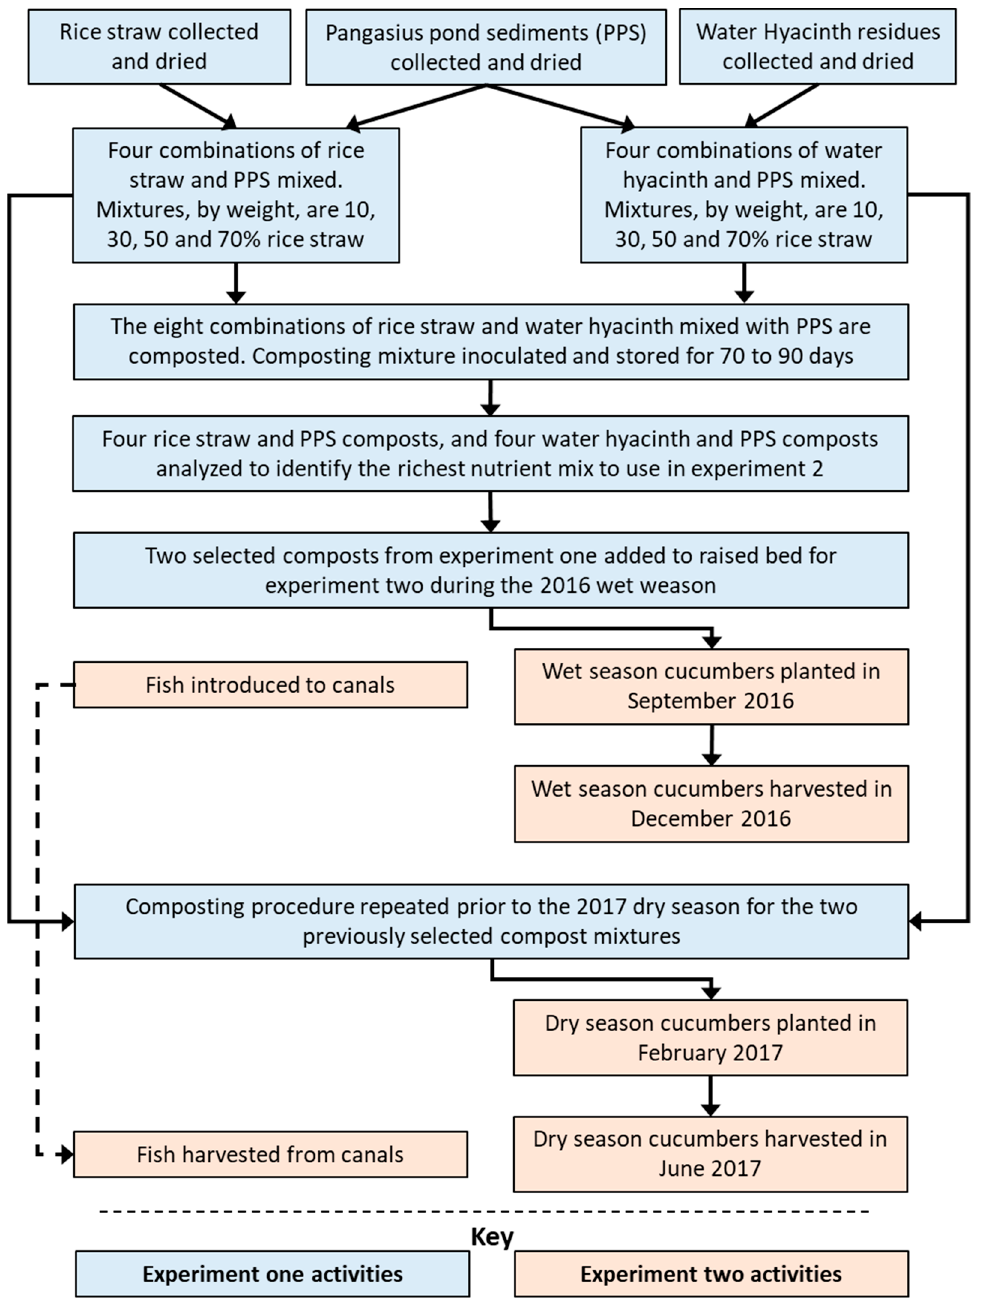
Figure 2. The work flow of experiments one and two. Light blue boxes represent activities included in experiment one; orange boxes are the activities of experiment two.